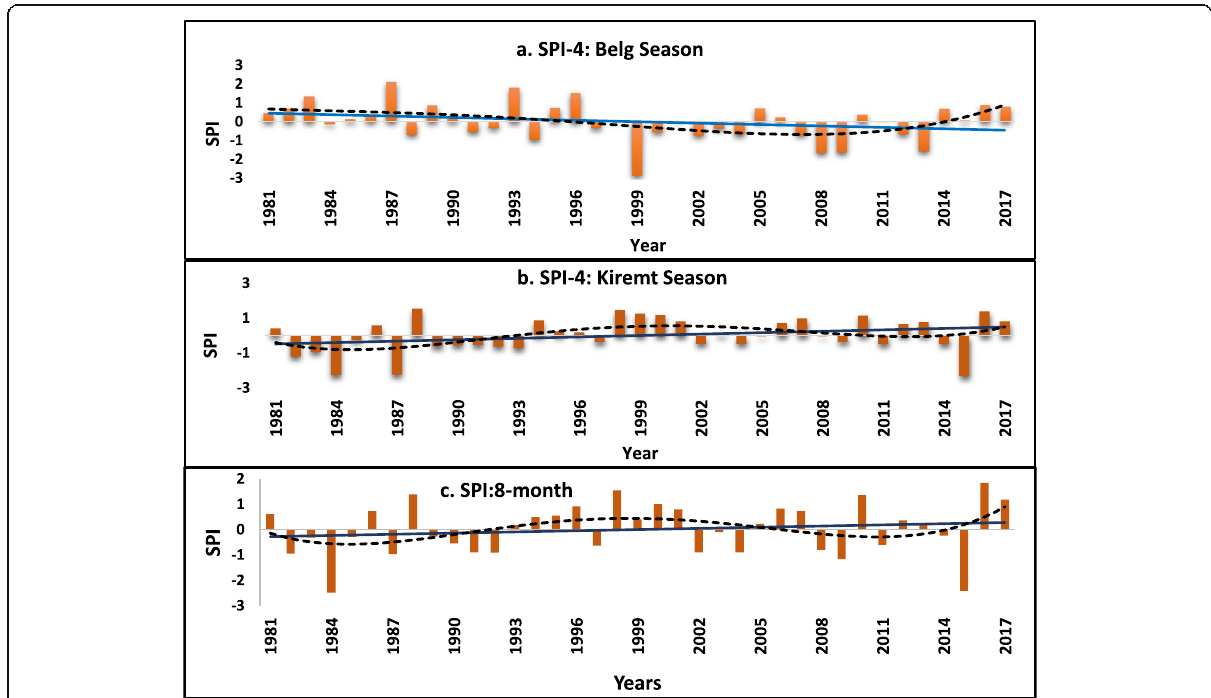
Fig. 4 The SPI anomalies and trends of the rainy seasons. a SPI-4: belg season (February-to-May); b SPI-4: kiremt season (June-to-September) and c SPI-8 long-term seasons